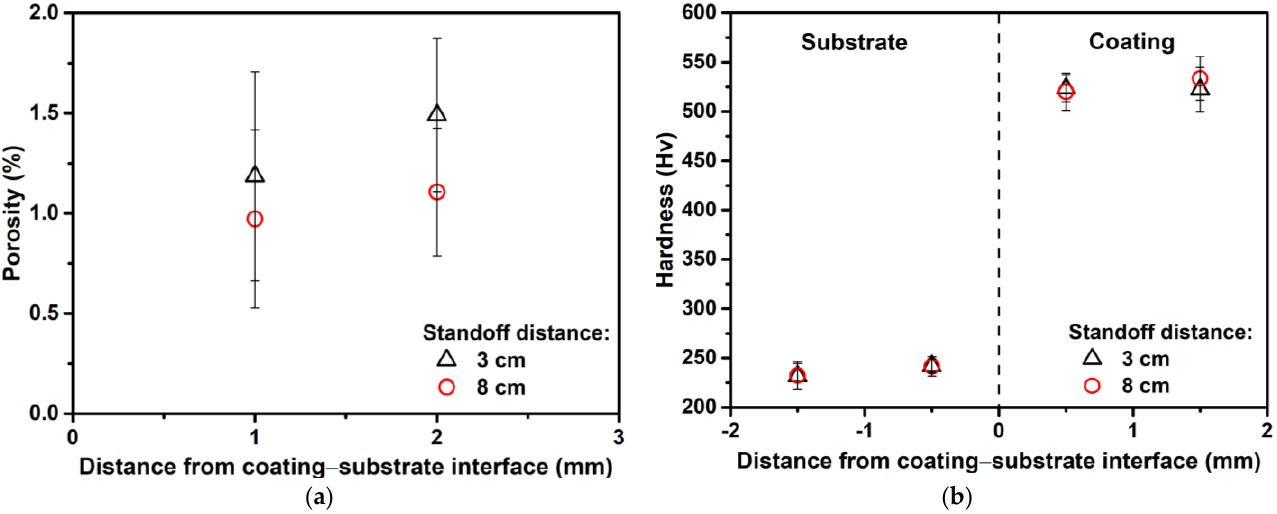
Figure 6. ( a ) Porosity in the coatings and ( b ) hardness results of Inconel 625 coating at 3 and 8 cm standoff distances.